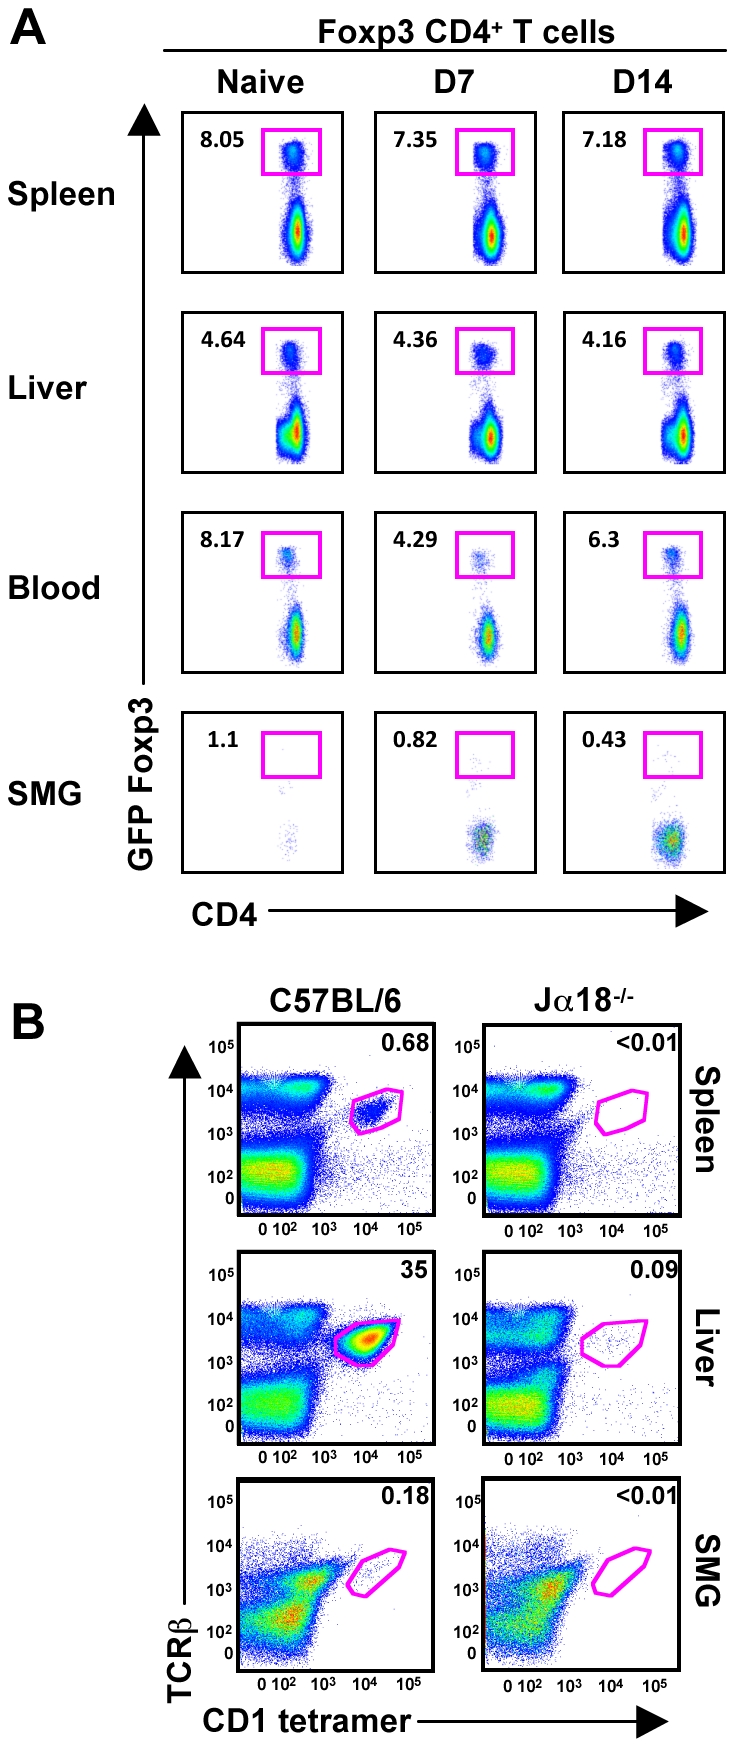
T-regs and iNKT cells are absent from naïve and MCMV infected SMG.
(A) Mice expressing a GFP-Foxp3 fusion-protein reporter were infected with MCMV for the time points shown and analyzed for accumulation of Tregs in the spleen, liver, blood and SMG as shown by CD4+GFP+ T cells. Representative of 3 separate experiments with 3–4 mice per group. (B) Splenic, hepatic and SMG leukocytes were isolated from naïve B6 and Jα18 deficient mice. The iNKT cell compartment was analyzed by staining with TCR-β and α-GalCer-loaded CD1d tetramer. Representative of 3 separate experiments with 2–3 mice per group.